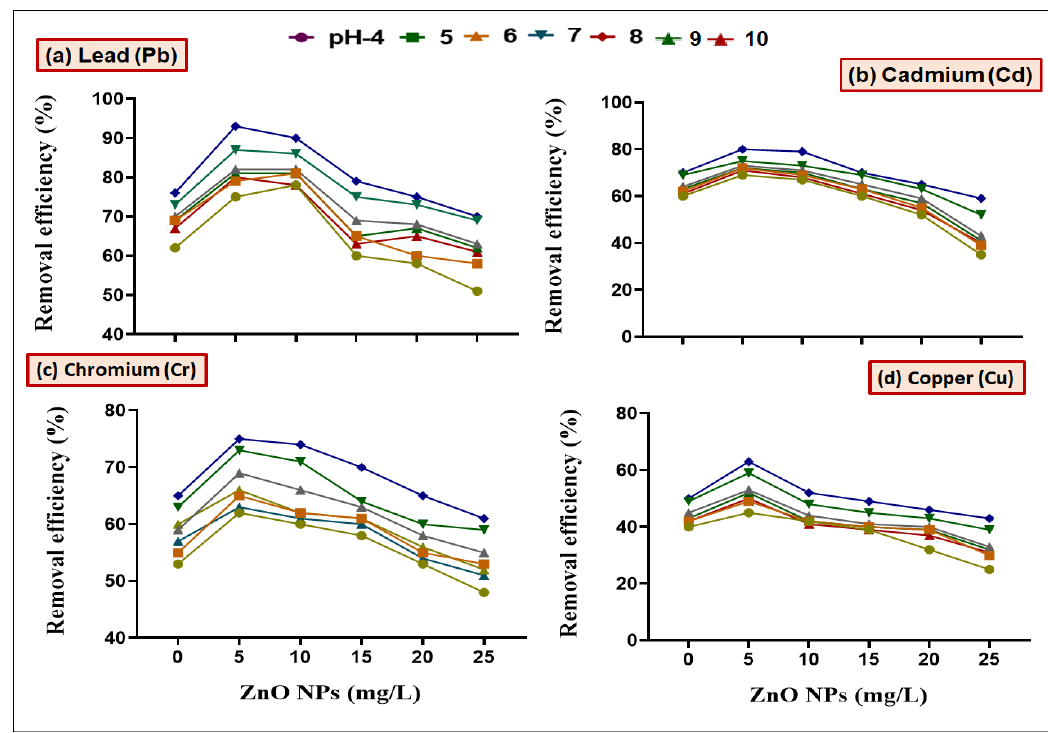
Figure 2. Synergistic effect of L. macroides and ZnO NPs (5, 10, 15, 20 and 25 mg/L) on the removal efficiency of ( a ) Lead (Pb), ( b ) Cadmium (Cd), ( c ) Chromium (Cr) and ( d ) Copper from the media amended with heavy metal at different pH (4, 5, 6, 7, 8, 9 and 10).